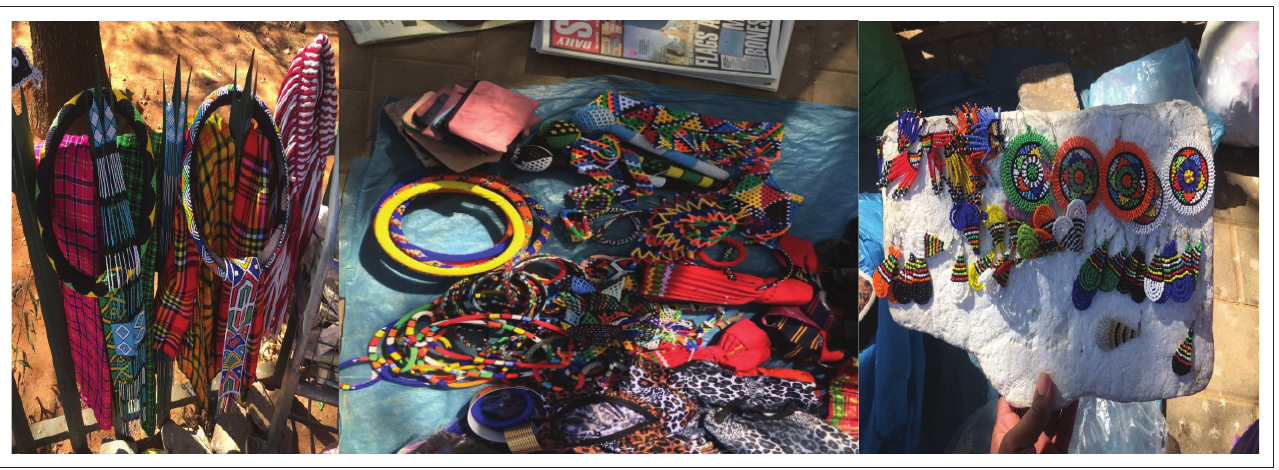
Source : Photos taken by the author. FIGURE 4: Accessories sold by the